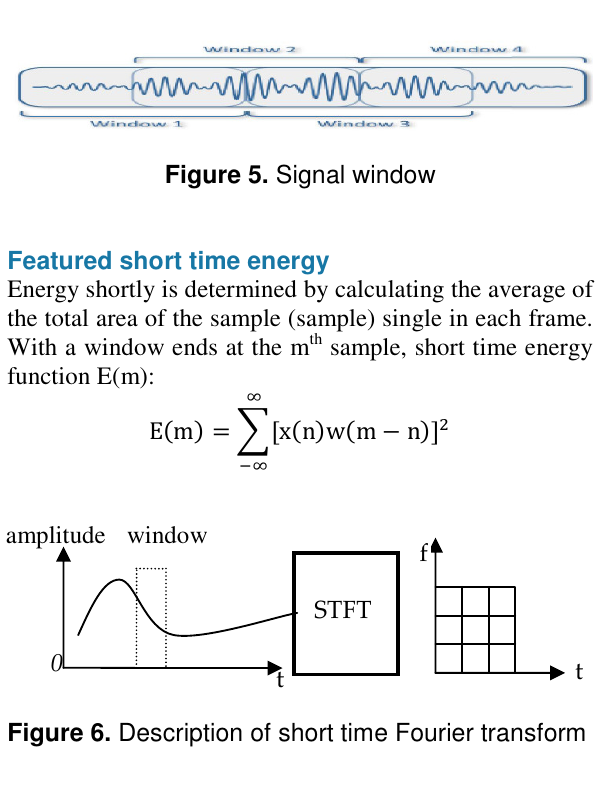
Frequency signals emitted from the hand gestures or environmental noise signal with non-stop (non-stationary signals) means a periodic signal over time. Short-time energy analysis after each frame signal is unstable, or undetailed process of moving gesture or noise already existing or appearing at random. So we continue to separate into discrete signal on each frame (framing) using short-time Fourier transforms.